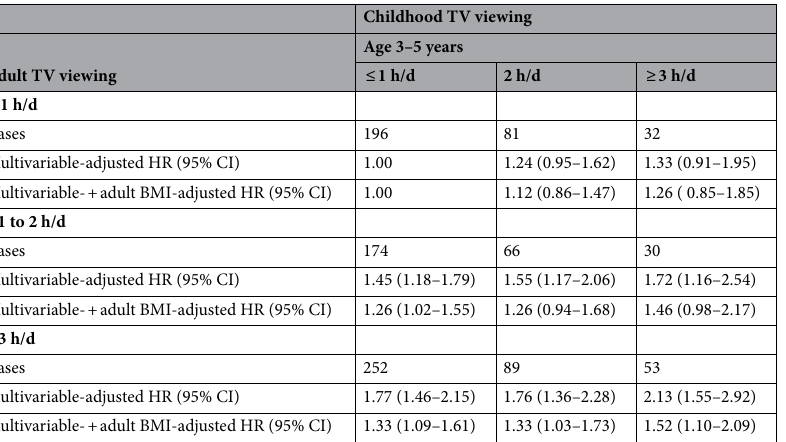
Table 4. Joint associations of TV viewing at ages 3–5 years and during adulthood with diabetes in adult life among participants of the Nurses’ Health II cohort between 2001 and 2013. TV television, HR hazard ratio, CI confidence interval. Multivariable model adjusted for age of nurse (continuous) and follow-up cycle, race (White, Non-White), family history of diabetes (yes, no), maternal education (1–3 yrs of high school or less’, 4 yrs of high school, 1–3 yrs of college, 4 + yrs of college), maternal pre-pregnancy body mass index (quintiles), paternal body mass index at nurses’ birth (quintiles), maternal weight gain during pregnancy (< 10 lbs, 10–14 lbs, 15–19 lbs, 20–29 lbs, 30–40 lbs, ≥ 40 lbs), maternal smoking during pregnancy [no smoking during pregnancy, quit smoking during pregnancy, light smoker (< 15 cigarettes/day), heavy smoker (≥